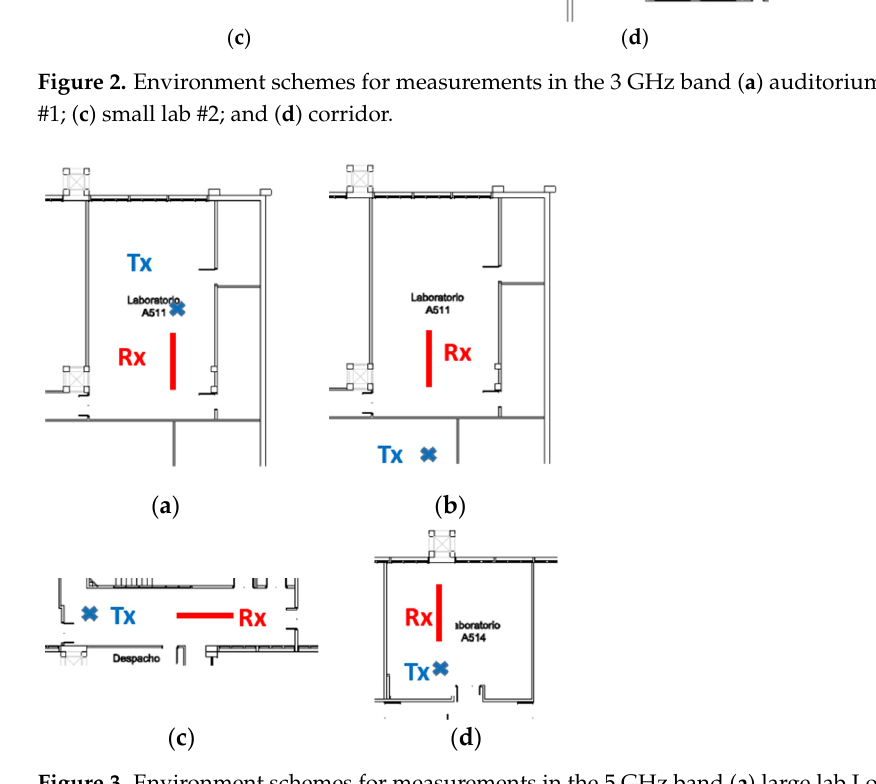
Figure 2. Environment schemes for measurements in the 3 GHz band ( a ) auditorium; ( b ) small lab #1; ( c ) small lab #2; and ( d ) corridor.